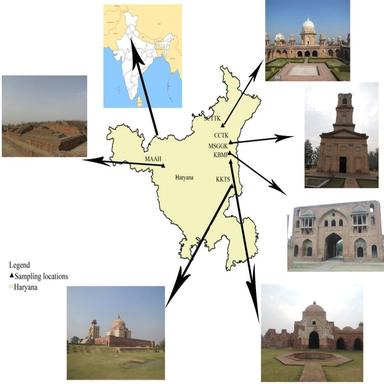
Map of Haryana with study sites.